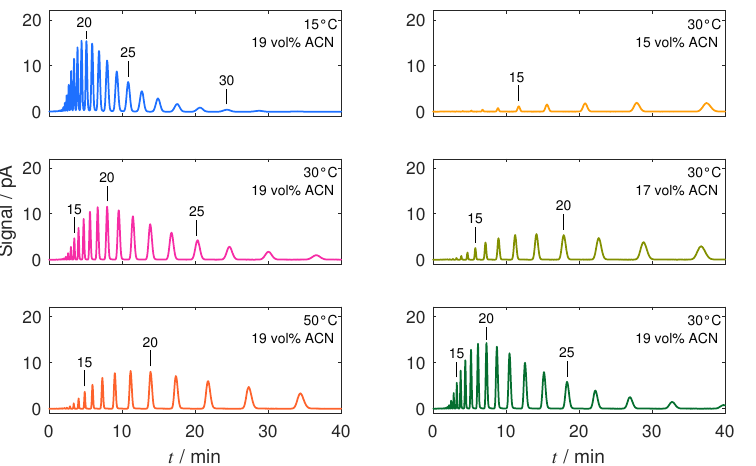
Figure 2. Example chromatograms demonstrating the roles of temperature and mobile phase compo- sition for the separation of PEG 1000 on the preparative column. For better orientation, peaks are marked for the homologs with n = 15, 20, and 25. ( Left ) three different temperatures (15, 30, 50 ◦ C) at 19 vol% ACN in water as eluent. ( Right ) three different eluent compositions (15, 17, and 19 vol% ACN in water) at 30 ◦ C. Remark: The chromatogram in the left (middle) is the same as the one in the right (bottom). Samples: 50 µ L of 5 g/L PEG 1000 in